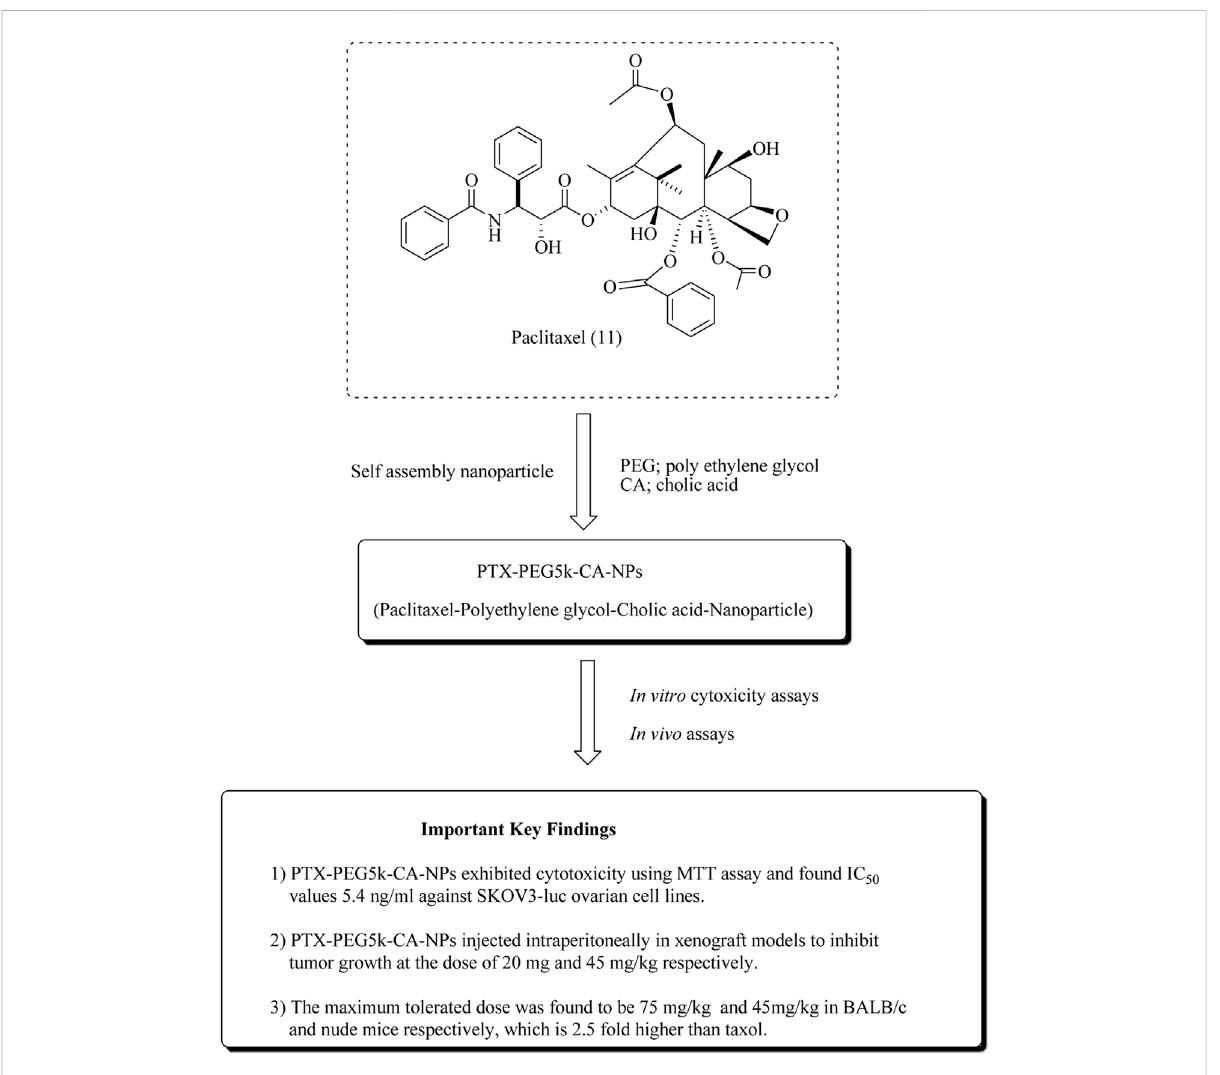
FIGURE 14 Anticancer potential of paclitaxel nanoparticles against ovarian cancer. PTX-PEG5k-CA-NPs were assessed for anti-ovarian cancer potential using in vitro and in vivo assays. SKOV-3-Luc cell lines and BALB/c and nude mice were